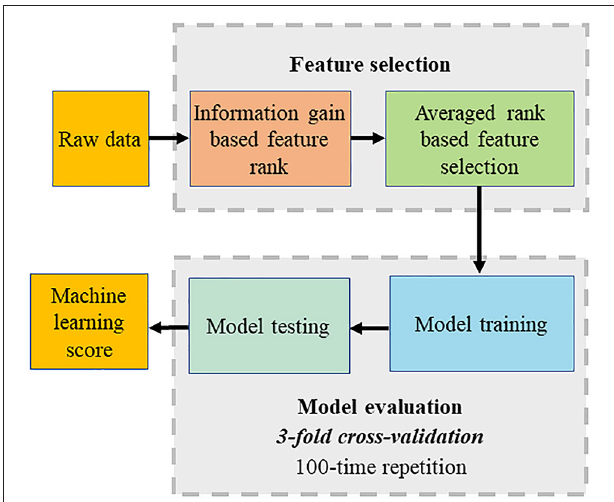
FIGURE 1 | Computational methods. The machine learning (ML) process included automated feature selection by information gain ranking using four different methods, averaging the results of information gain ranking, model building (LogiBoost), 3-fold stratified cross-validation, and repletion for 100